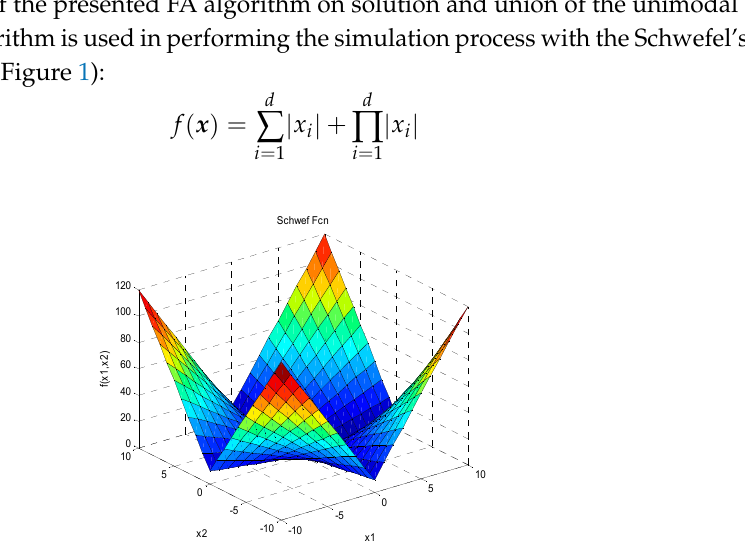
Figure 1. Schwefel’s Problem in 3-D view.